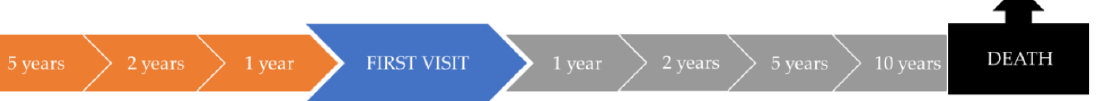
Figure 1. Follow-up strategy for data extraction.